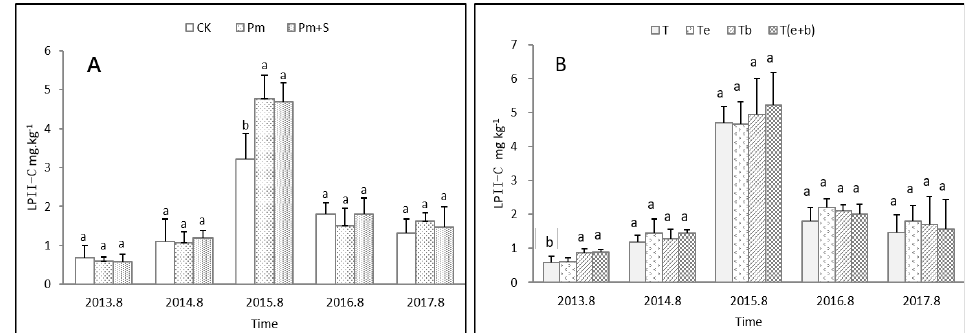
Figure 6. Dynamic change of organic carbon (active component II) content in soil by strong acid leaching. Bars represent standard errors. Lower case letters above each panel show statistical signif-icance at p < 0.05. CK pig manure, S slurry, e earthworms, b bacteria, T Pm + S, Te T + earthworms, Tb T + bacteria, T(e + b) T + earthworms + bacteria ( A ) Pig manure, biogas slurry agricultural use ( B ) Biological